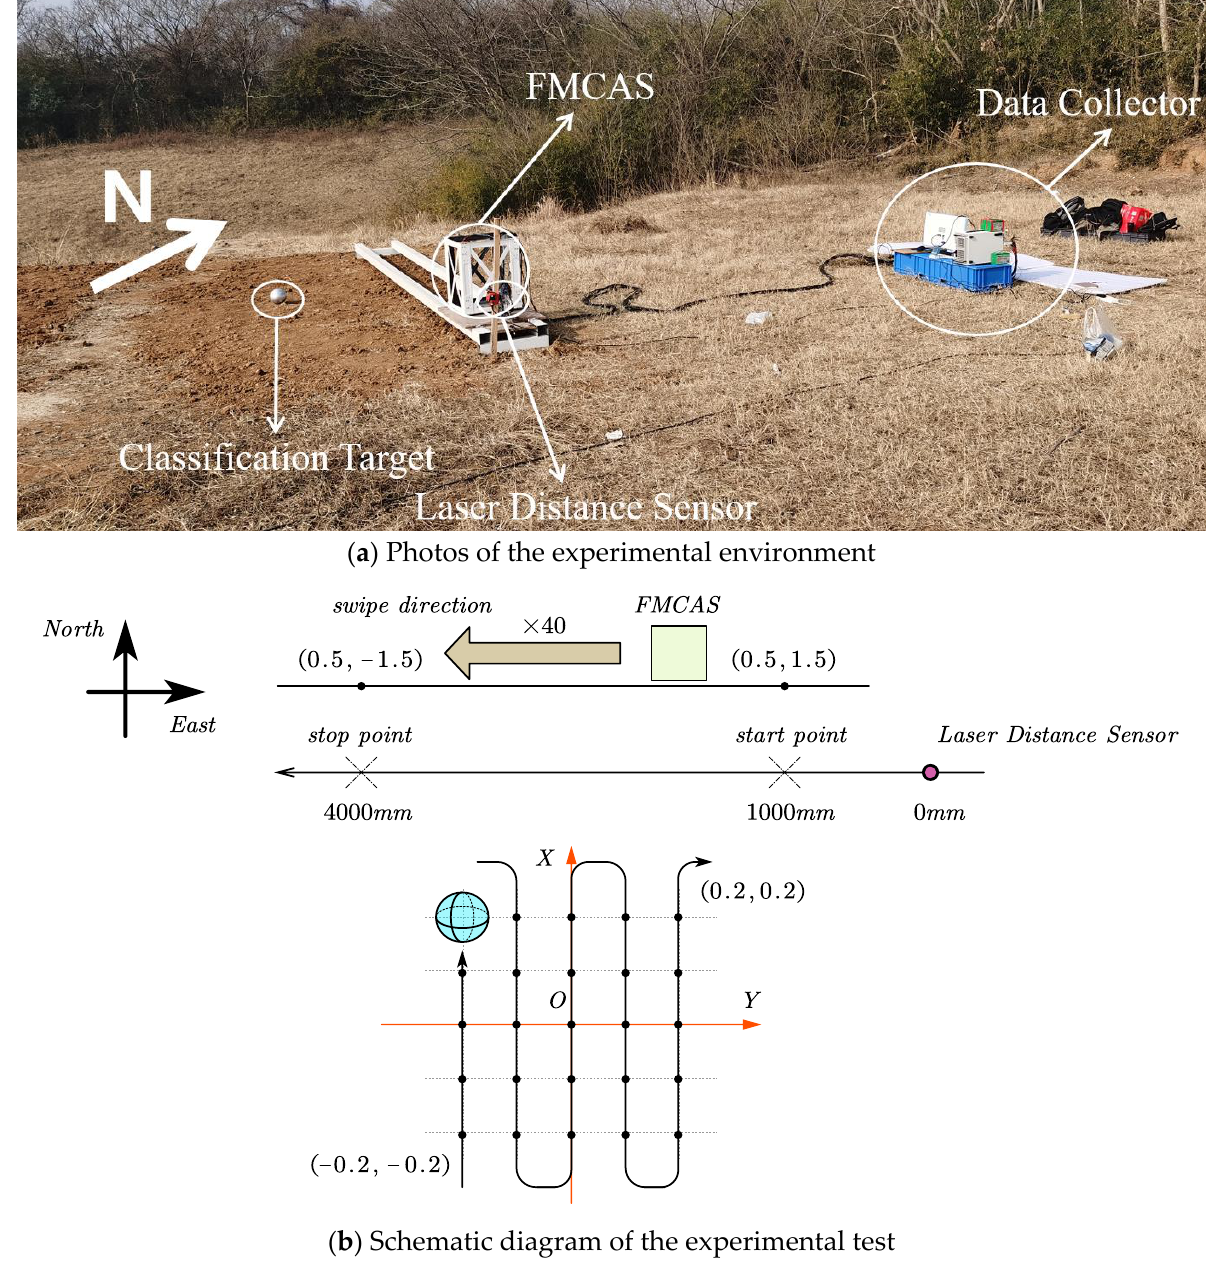
Figure 5. Experimental site map and experimental schematic. The starting position of each probe target is ( − 0.2, − 0.2), and the end position is (0.2, 0.2). The target moves 0.1 m along the x-axis each time. When the x-axis coordinate of the target reaches 0.2 m, the target moves 0.1 m along the y-axis. The x-axis position of the target is repeatedly adjusted to complete a cycle. The target has a total of 25 position points; for each position point, FMCAS slides 40 times. Each target to be tested has a total of 1000 groups of data, which are used as the training set for deep learning. The targets are randomly arranged in 5 random positions within a square area from ( − 0.2, − 0.2) to (0.2, 0.2), and the FMCAS is also slid 40 times, with a total of 200 groups of data for each target, as the test set of deep learning. The three targets we measured and their effective data during the experiment are shown in Table 3. During the follow-up experimental processing, we found a set of experiments where the laser distance sensor did not capture the entire sliding distance of